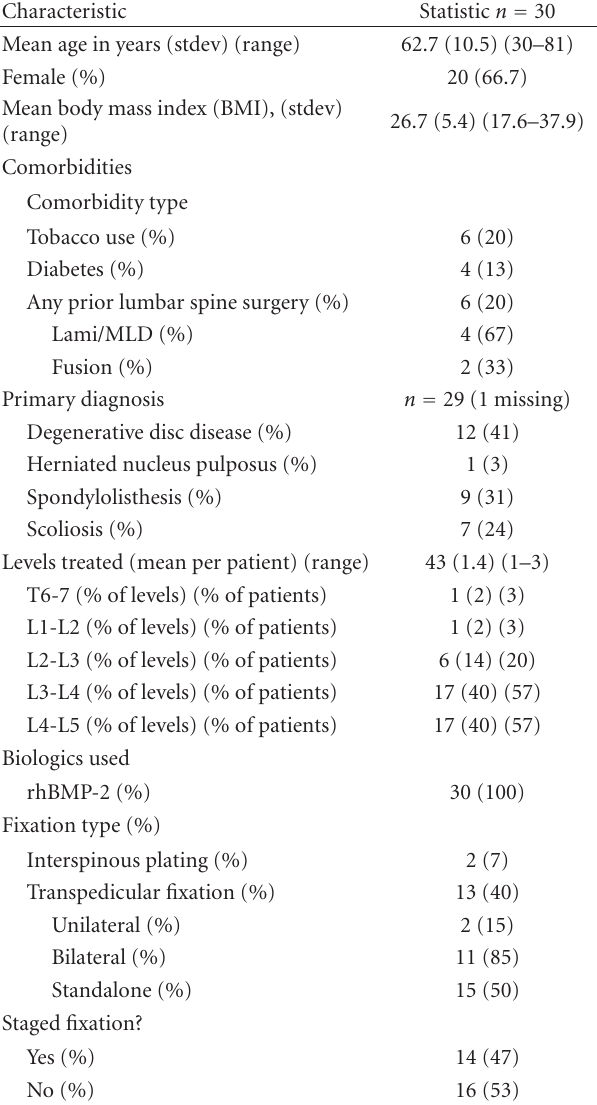
Table 1: Listing of patient demographic and treatment informa- tion.